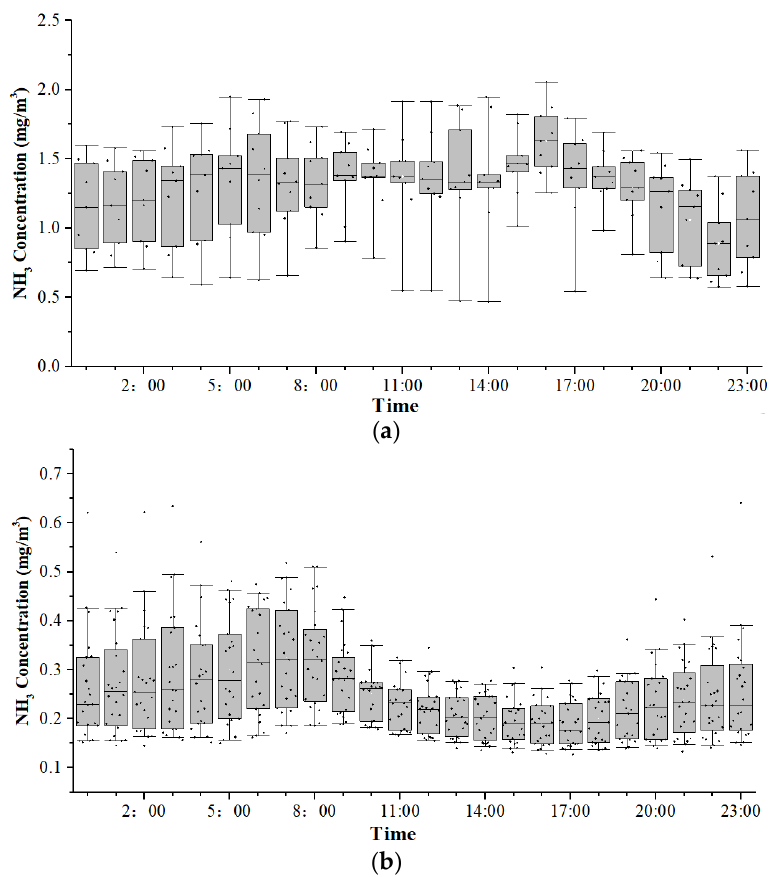
Figure 7. Box plot of hourly average concentrations of NH 3 inside the pig house. ( a ) Winter; ( b ) Summer.